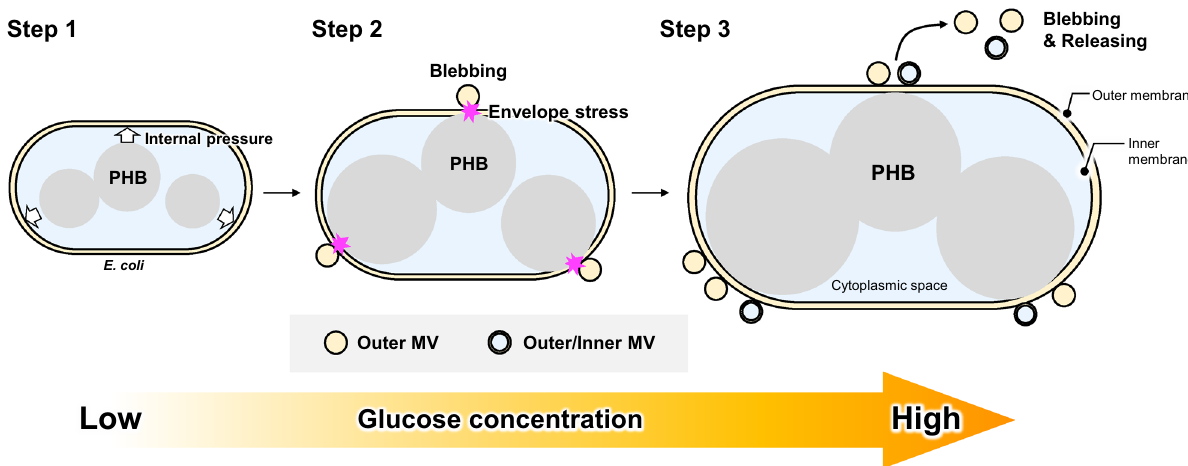
Figure 7. A hypothetical model for the Polymer Intracellular Accumulation-triggered system for MV Production (PIA-MVP). A hypothetical model for PIA-MVP is made based on the following these three steps. (Step 1) PIA-MVP would take place via the internal pressure caused by PHB accumulation. (Step 2) the internal pressure may give a physical perturbation to the linkage network formed between three structurered biomacromolecules, outer membrane-peptidoglycan-inner membrane. Consequently, a disordered state would be occurred in the periplasmic space as an envelope stress, causing MV biogenesis. (Step 3) single-layer MVs (Outer MVs, OMVs) and multilayer MVs (Outer/Inner MVs, OIMVs) frequently occur. The illustration was drawn by the drawing tool in Microsoft PowerPoint ver. 16.56